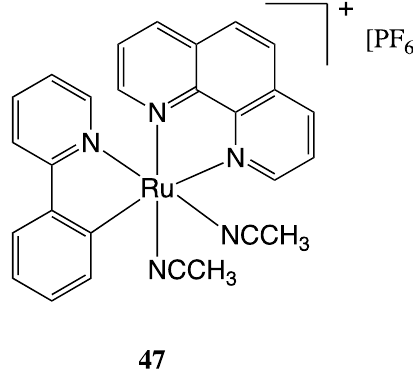
Figure 28. Structure of compound 47 .